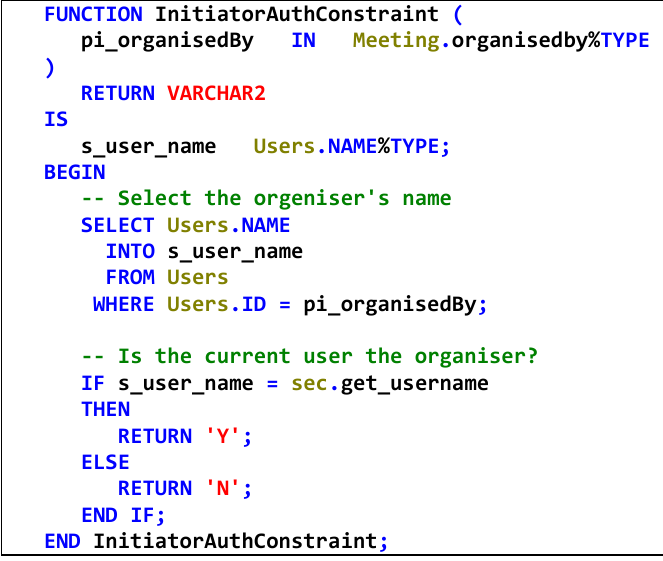
Figure A1. PL/SQL constraint InitiatorAuthConstraint